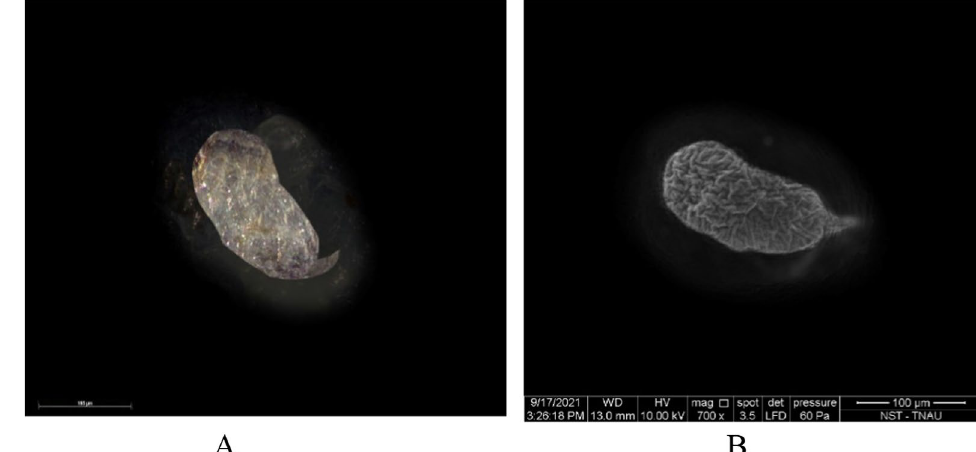
Fig. 3 A, B Egg stage of T.